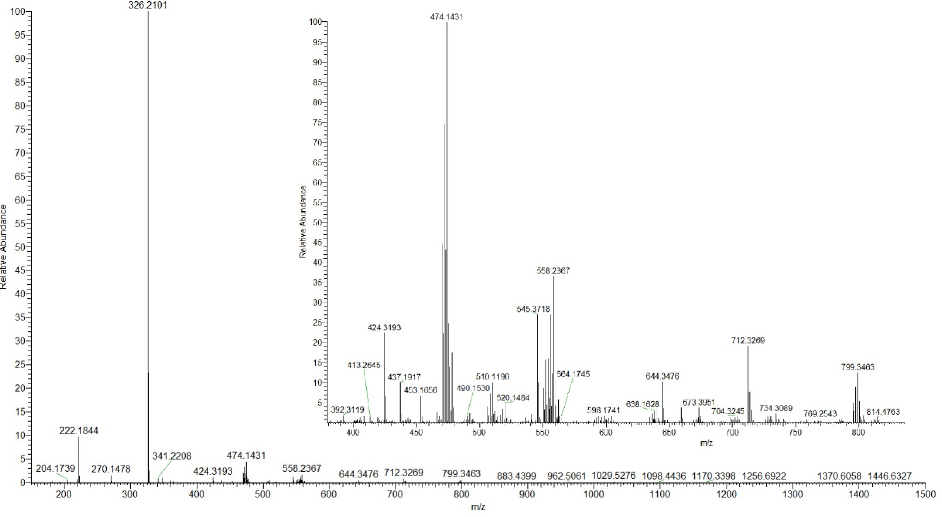
Figure 1. ESI mass spectrum of compound 1 .